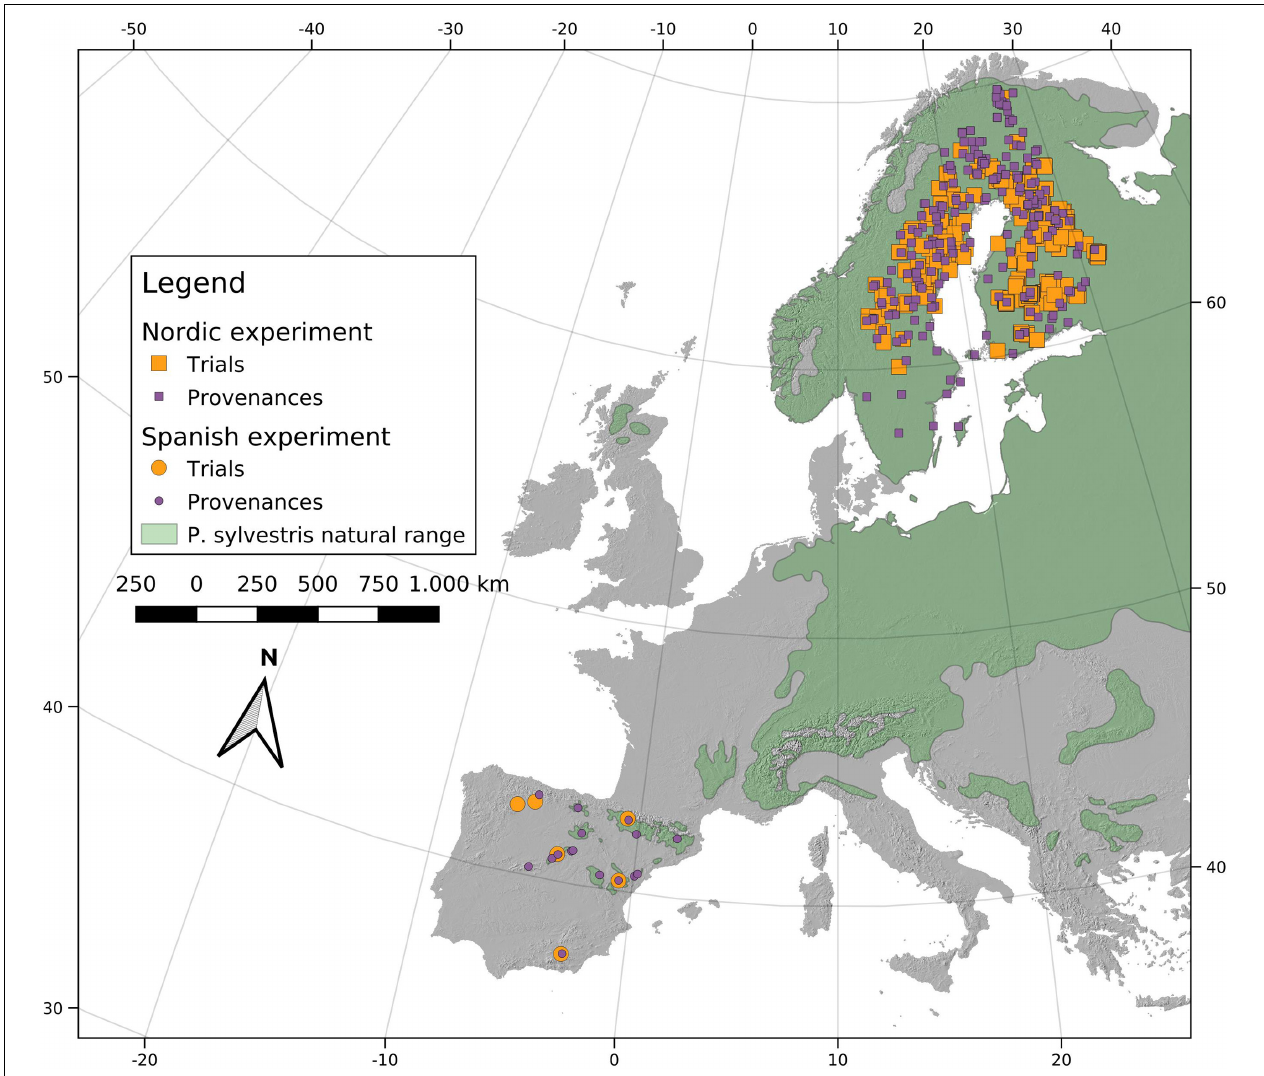
FIGURE 1 | Field trials and provenances planted in Sweden, Finland and Spain. The background area colored in green corresponds to the Scots pine native range (Caudullo et al., 2017).